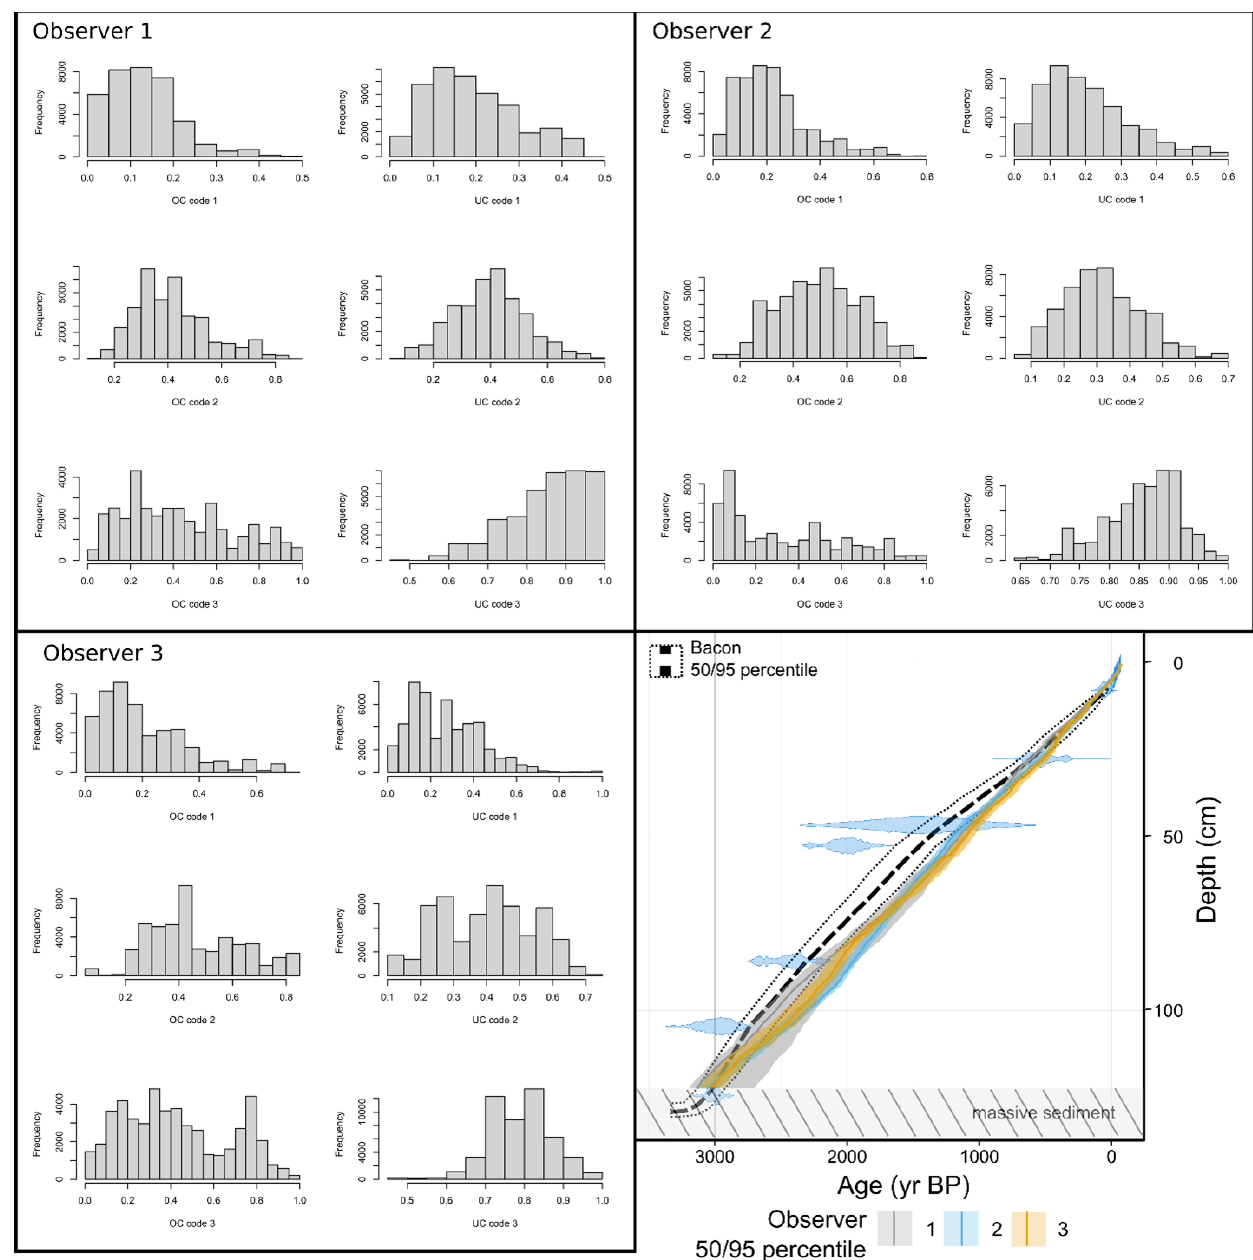
Figure A5. Posterior probabilities of over- and under-counting for each observer for core COL17-3. Comparison between independent and integrated age–depth model. OC: over-counting. UC: under-counting. Code 1–3 indicate the lamination quality codes